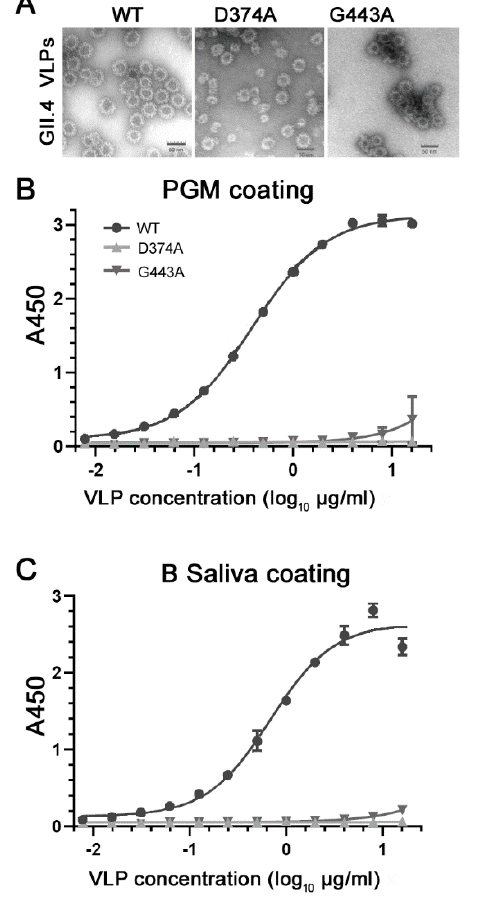
Figure 2. Characterization of the VLPs of HuNoV GII.4.HS194.2009 WT and its two mutants D374A and G443A by ( A ) transmission electron microscopy to show their sizes and morphology and by ( B